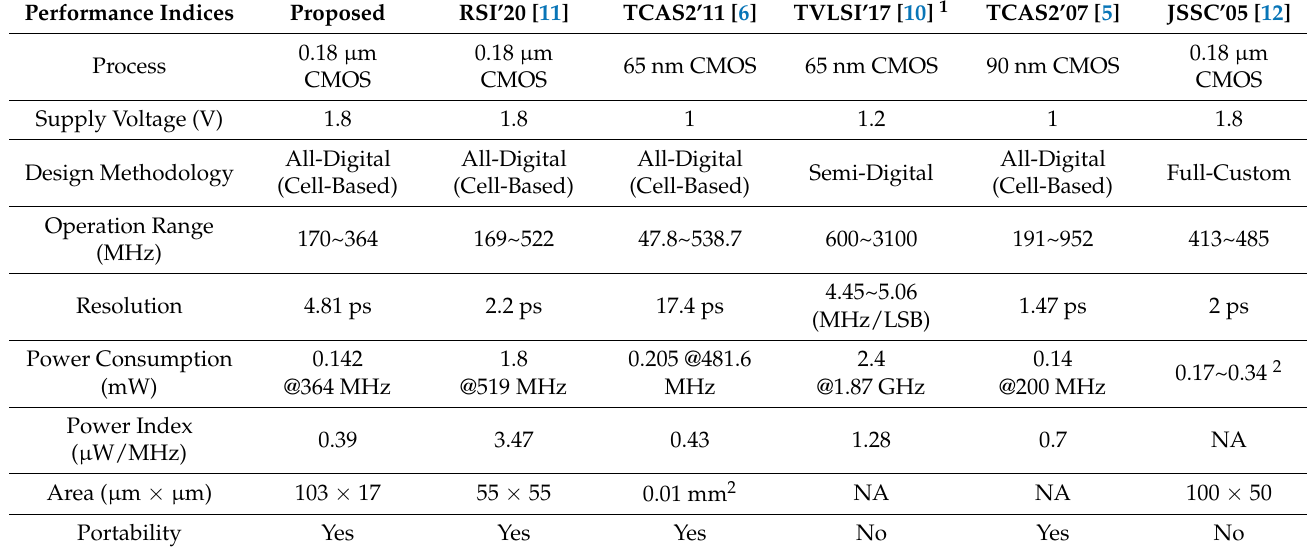
Table 3. Performance Comparisons.